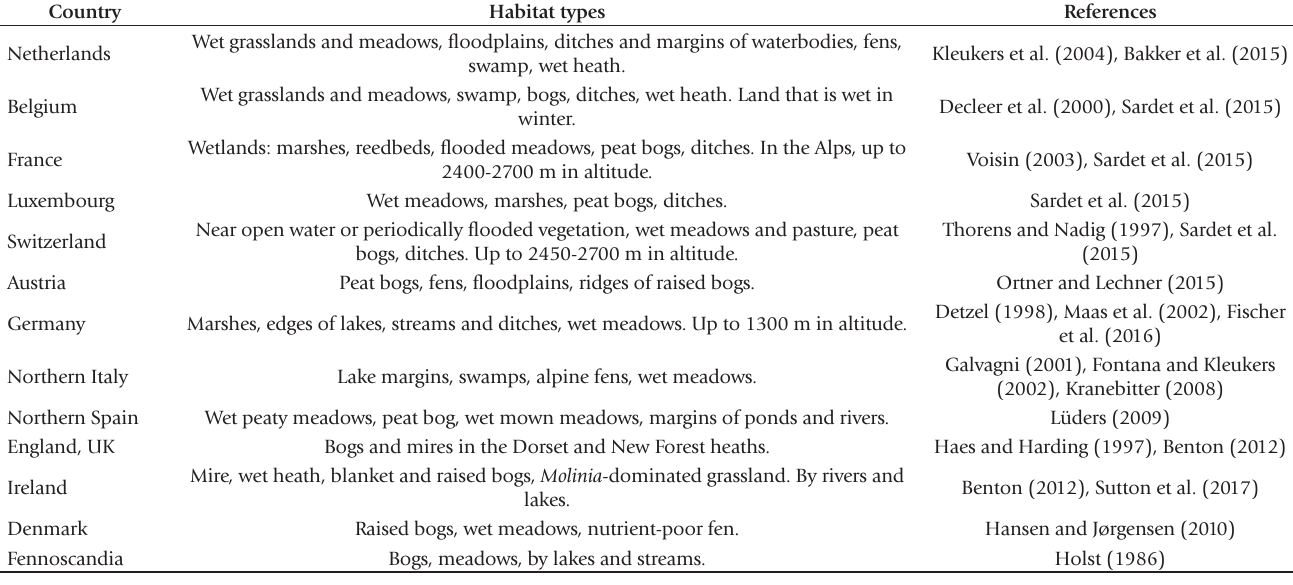
Table 1. Habitats of S. grossum in Western Europe. Country Habitat